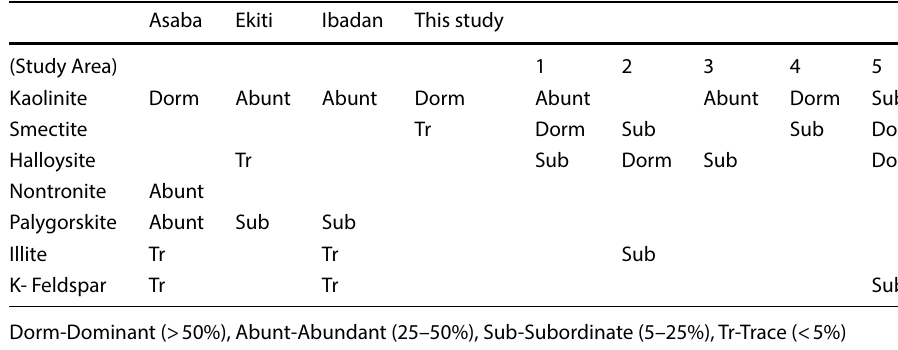
Table 6 Comparison of Geophagic Clay in this study with other parts of Nigeria and the